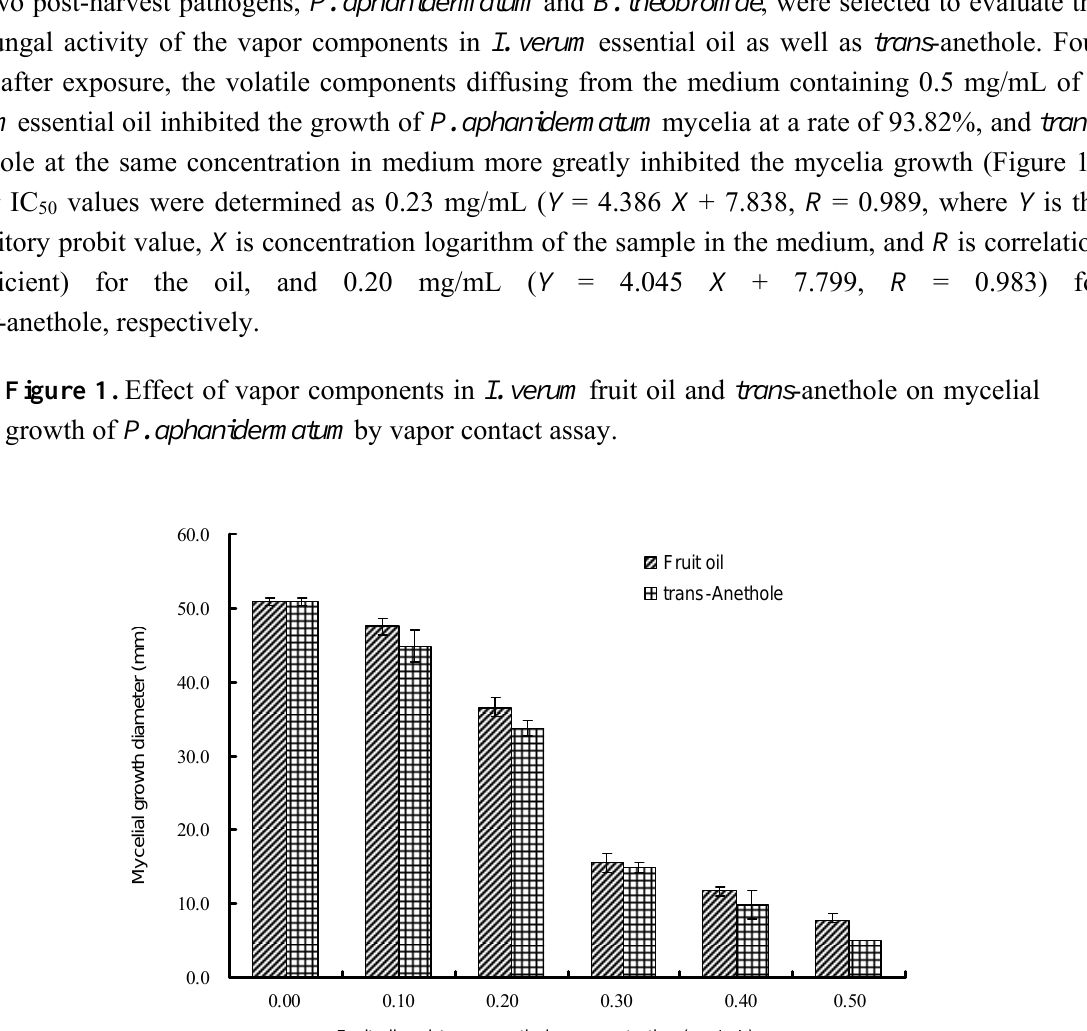
Table 2. Antifungal activity (IC pathogenic fungi.